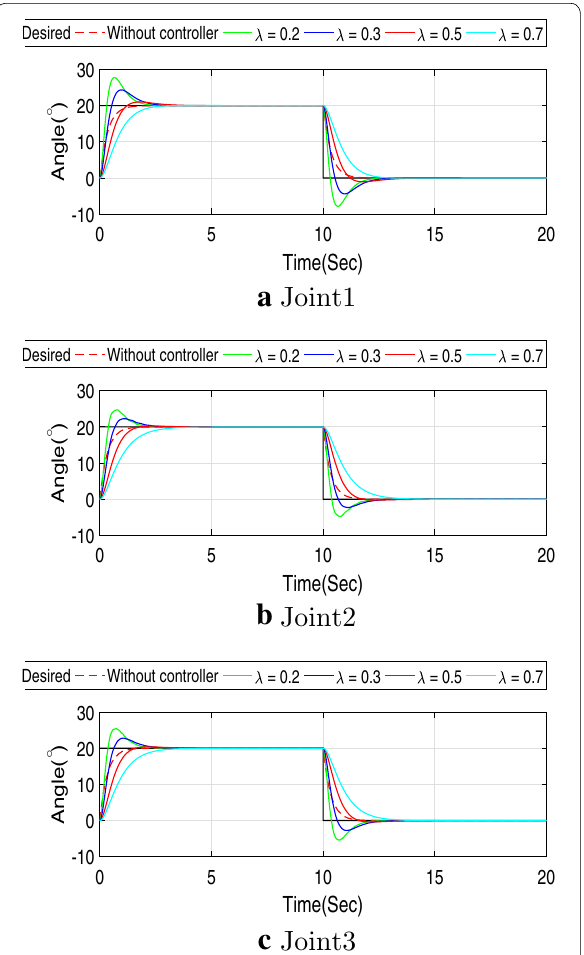
Fig. 10 Joint trajectories for varying (cid:31) . The black curve show the desired trajectory while the dotted curve show the response without the filter augmented inverse